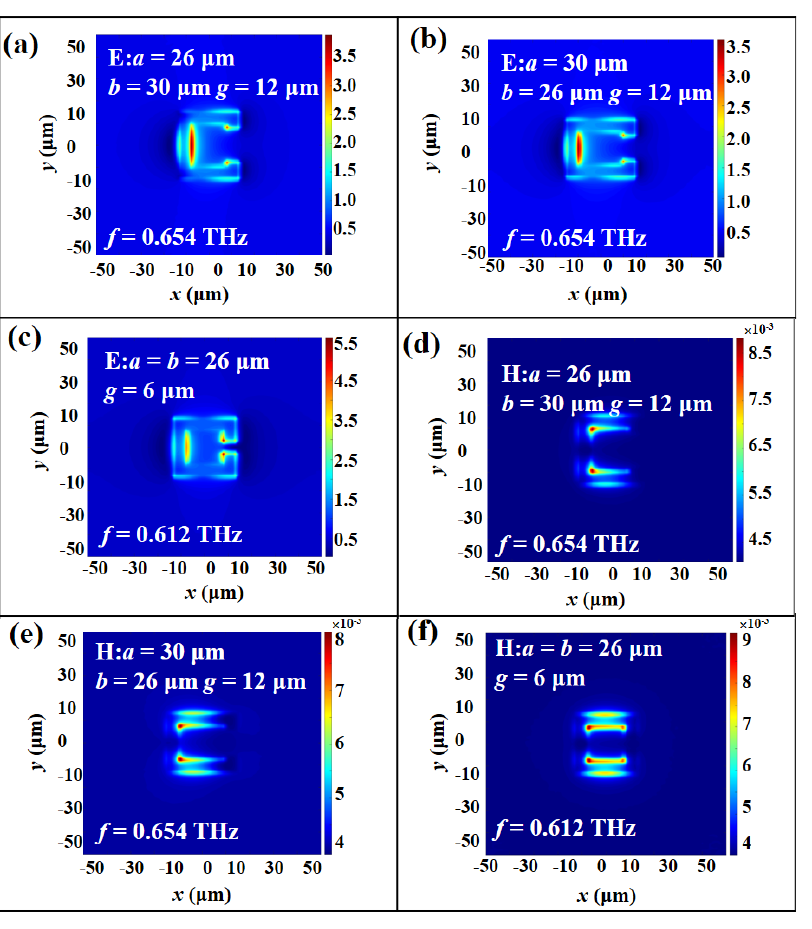
Figure 4 Figure 4. ( a – c ) E– and ( d – f ) H–field distributions of MTM at the condition of a , b , and g values in TE